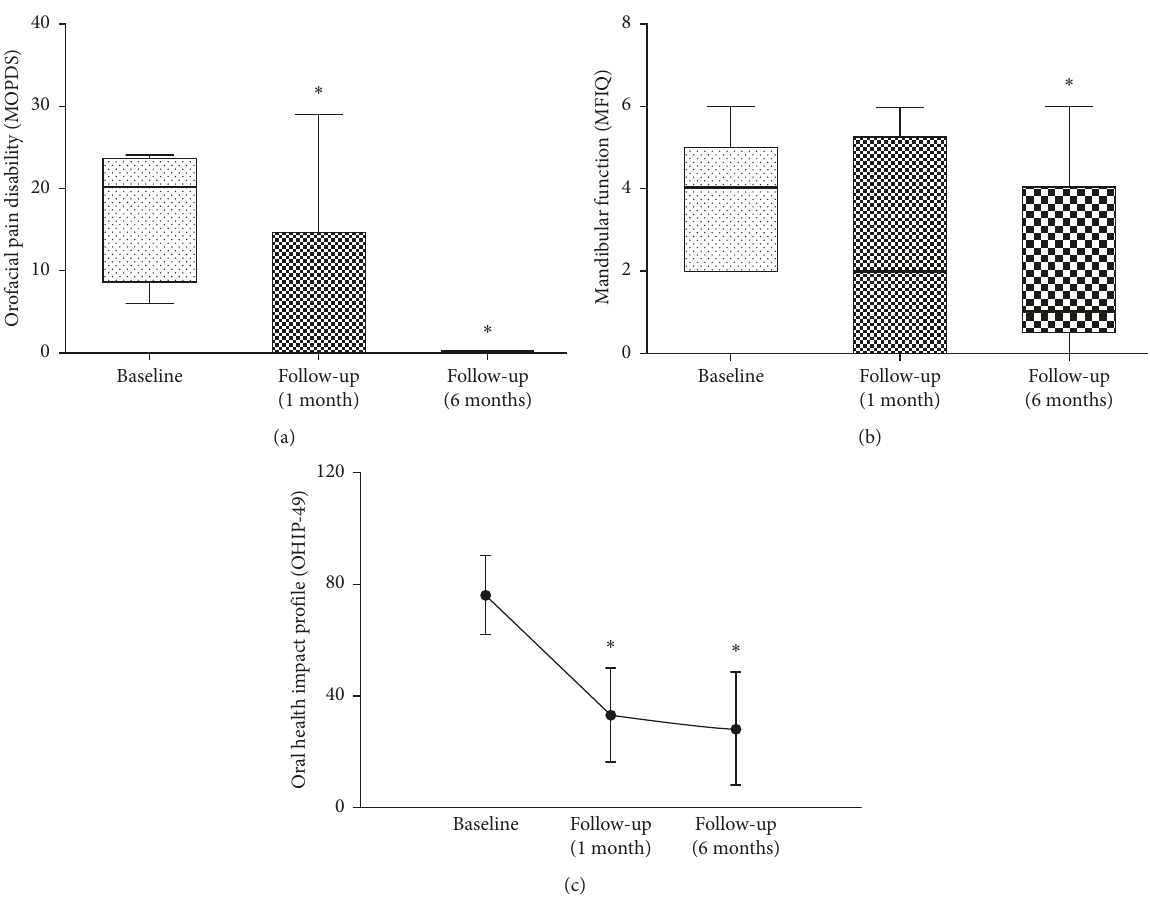
Figure 2: (a) Improvement on orofacial pain disability at 1 and 6 months after treatment. This parameter was analyzed only on patients who showed pain at baseline. Box and whisker show quartiles, the band inside the box is the median, and the ends of the whiskers represent minimum p and maximum values. Wilcoxon signed rank test; 0 . 042 (1-month follow-up) and p 0 . 05 (6-month follow-up); n 6 patients (1-month (cid:31) (cid:31) (cid:31) follow-up) and 4 patients (6-month follow-up). (b) Improvement on mandibular function MFIQ at 6 months after treatment. Box and whisker ∗ show quartiles, the band inside the box is the median, and the ends of the whiskers represent minimum and maximum values. Wilcoxon signed rank test;